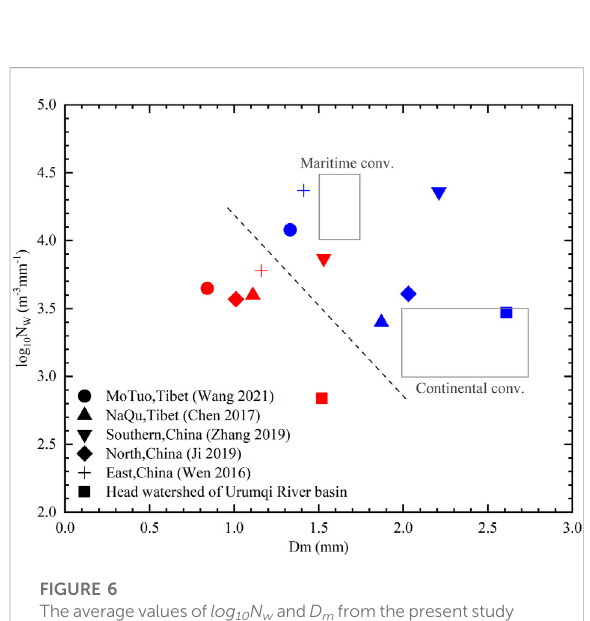
FIGURE 6 Theaveragevaluesof log 10 N w and D m fromthepresentstudy and previous literature are distinguished by the different symbols, as explained in the legend. The blue/red symbols represent convective/stratiform precipitation. The outlined dark grey rectanglescorrespondtothemaritimeandcontinental convective